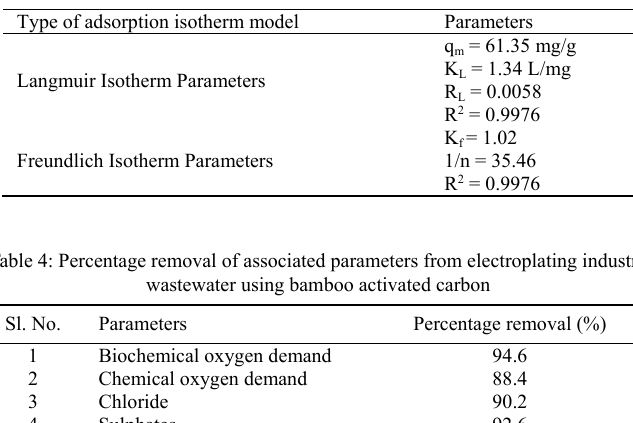
Table 3: Langmuir and Freundlich isotherm parameters for removing nickel from electroplating industry waster using bamboo activated carbon